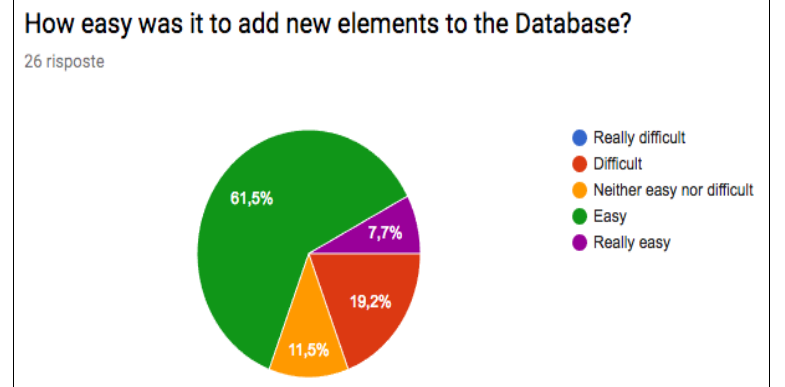
Figure 10. Difficulty of the procedure for inserting resources into the Database